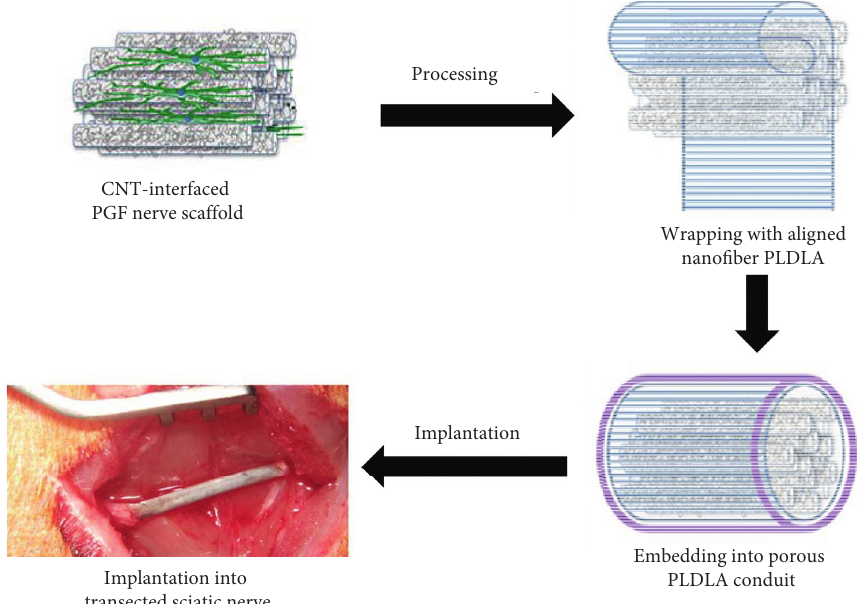
Figure 8: Functionality of a CNT-interfaced PGF scaffold used as nerve conduit. The aligned PGF bundle interfaced with CNTs for neurite outgrowth (adapted from reference [55]).